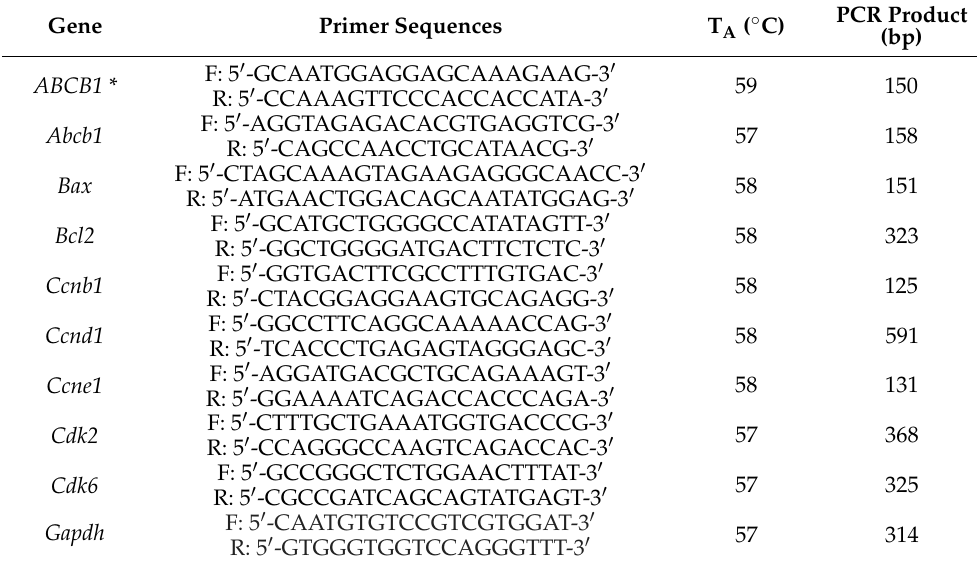
Table 3. PCR primers for estimation of respective genes.